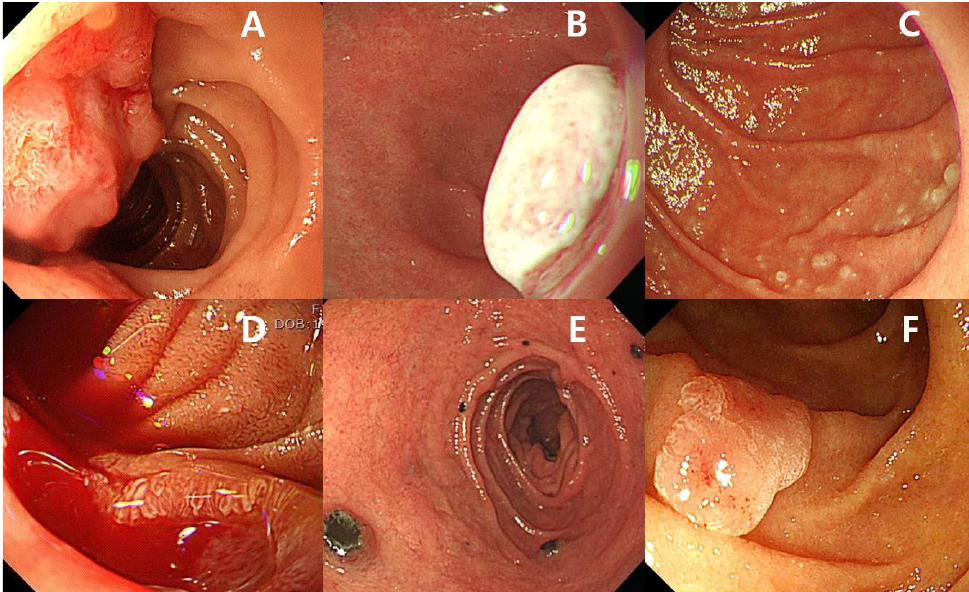
Figure 1. ( A ) Adenocarcinoma of the small bowel. ( B ) Neuroendocrine tumor of the small bowel. ( C ) Follicular lymphoma of the small bowel. ( D ) Gastrointestinal stromal tumor of the small bowel with active bleeding. ( E ) Secondary small bowel malignancy originating from malignant melanoma. ( F ) Adenoma of the small bowel.